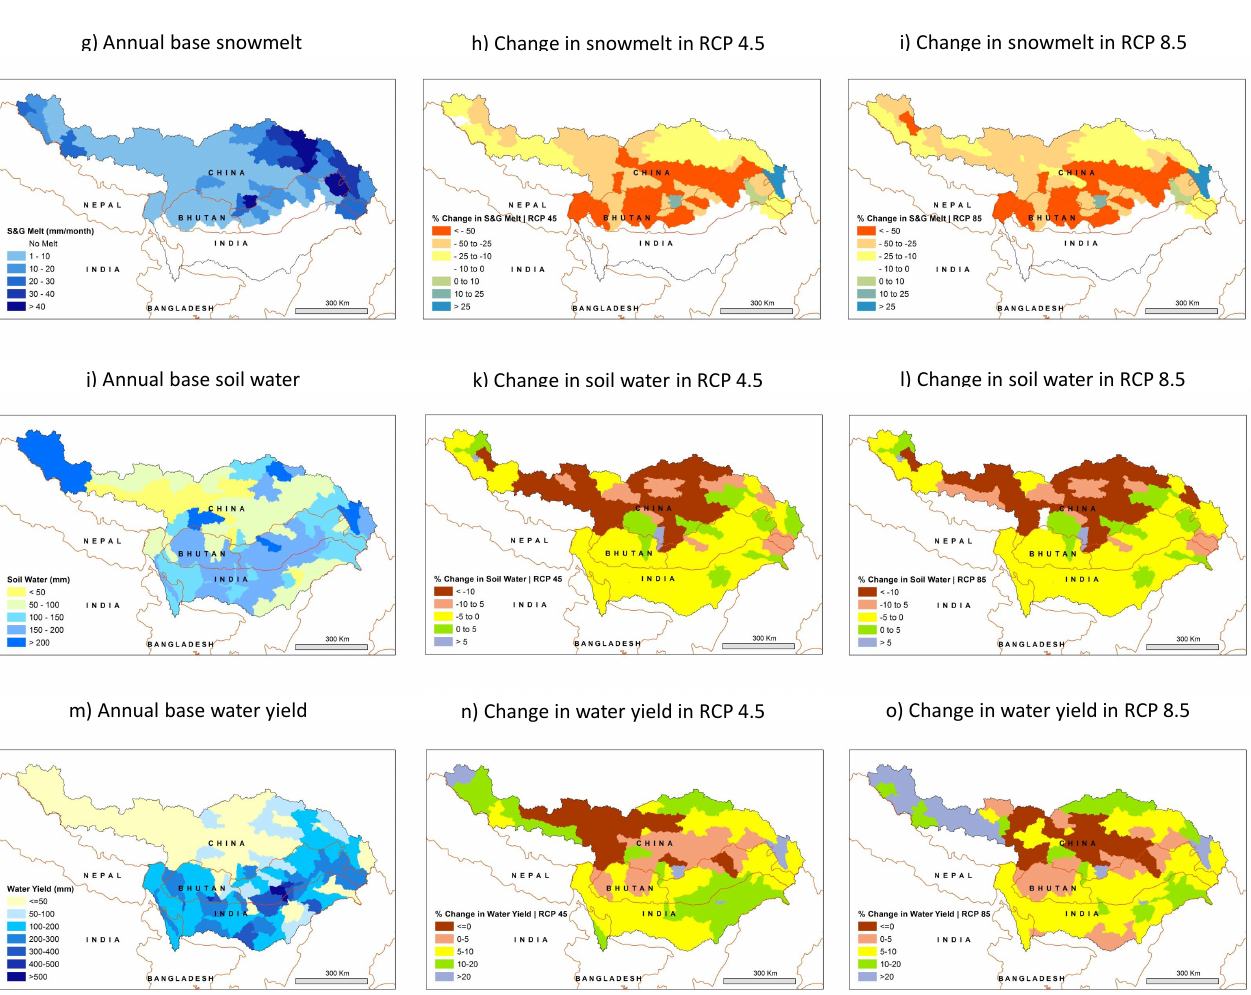
Figure 16. Spatial distribution of water balance components under the base condition and impact of climate change under the RCP 4.5 and 8.5